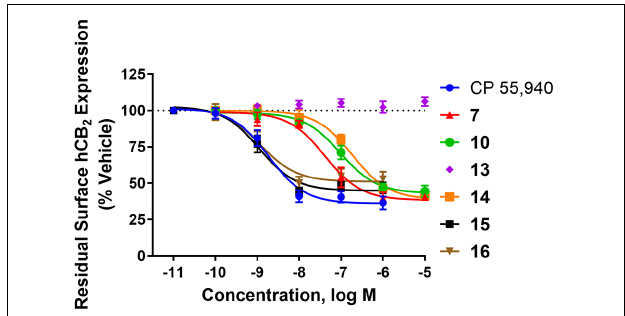
FIGURE 1 | Internalisation of hCB 2 in response to CP 55,940 and 2,4,6-trisubstituted 1,3,5-triazines. Internalisation of hCB 2 in HEK Flp-in hCB 2 cells in response to a 1 h stimulation with varying concentrations of CP 55,940 or test compounds. Data are presented as mean ± SEM from 3–4 independent experiments, and were normalised to vehicle-treated (100%).